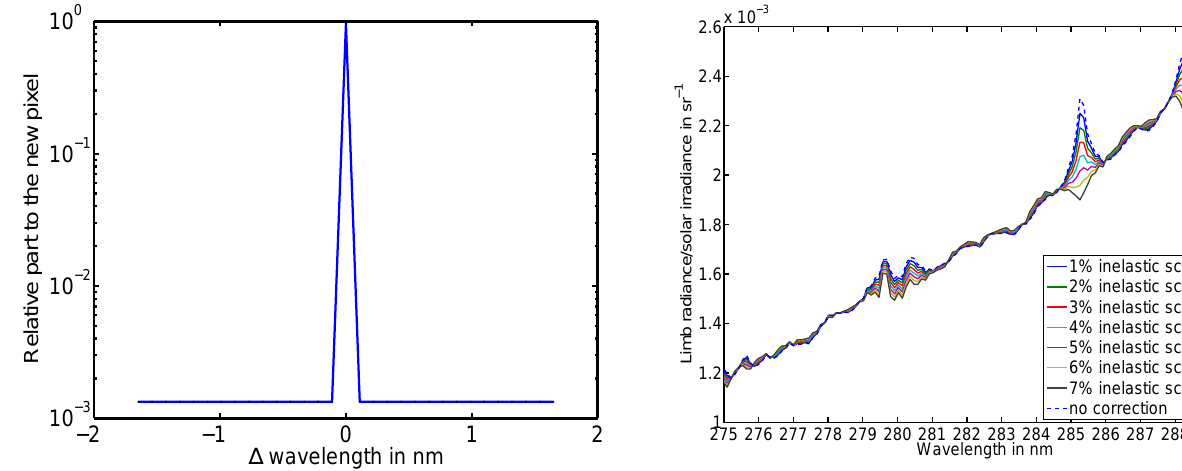
Fig. 5. Ring effect smoothing function. 96% of the background light is Rayleigh scattered. The Raman scattered part is approxi- mated with a boxcar for the remaining 4%.